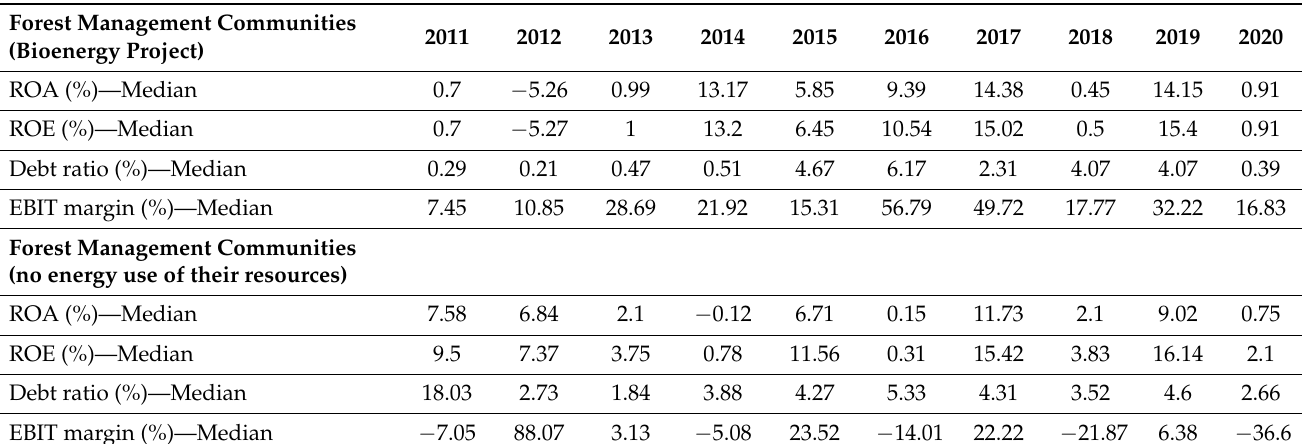
Table 3. Economic performance indicators of the two groups of forest management communities at the aggregate